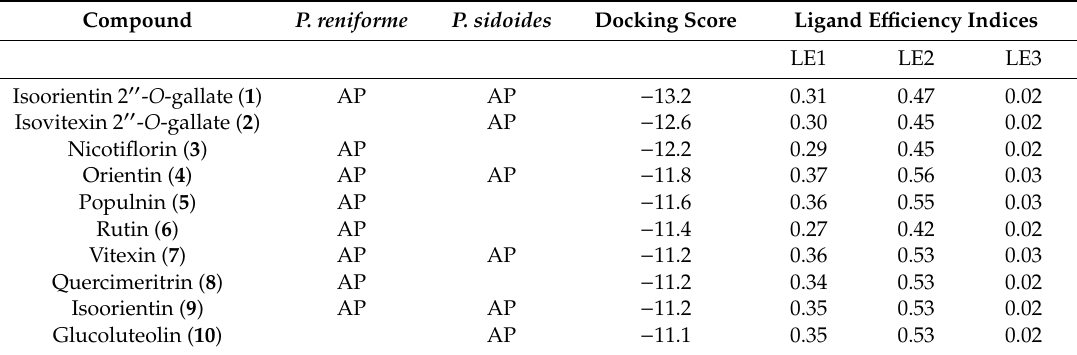
Table 2. Origin of Pelargonium natural products ( 1–10 ), and their predicted free binding energy